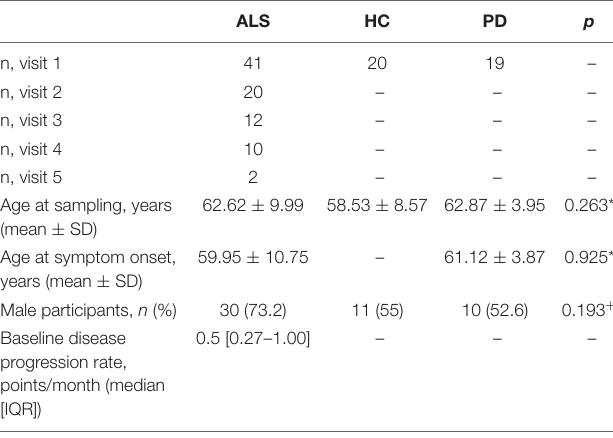
TABLE 1 | Baseline demographic features of participants included in WGCNA